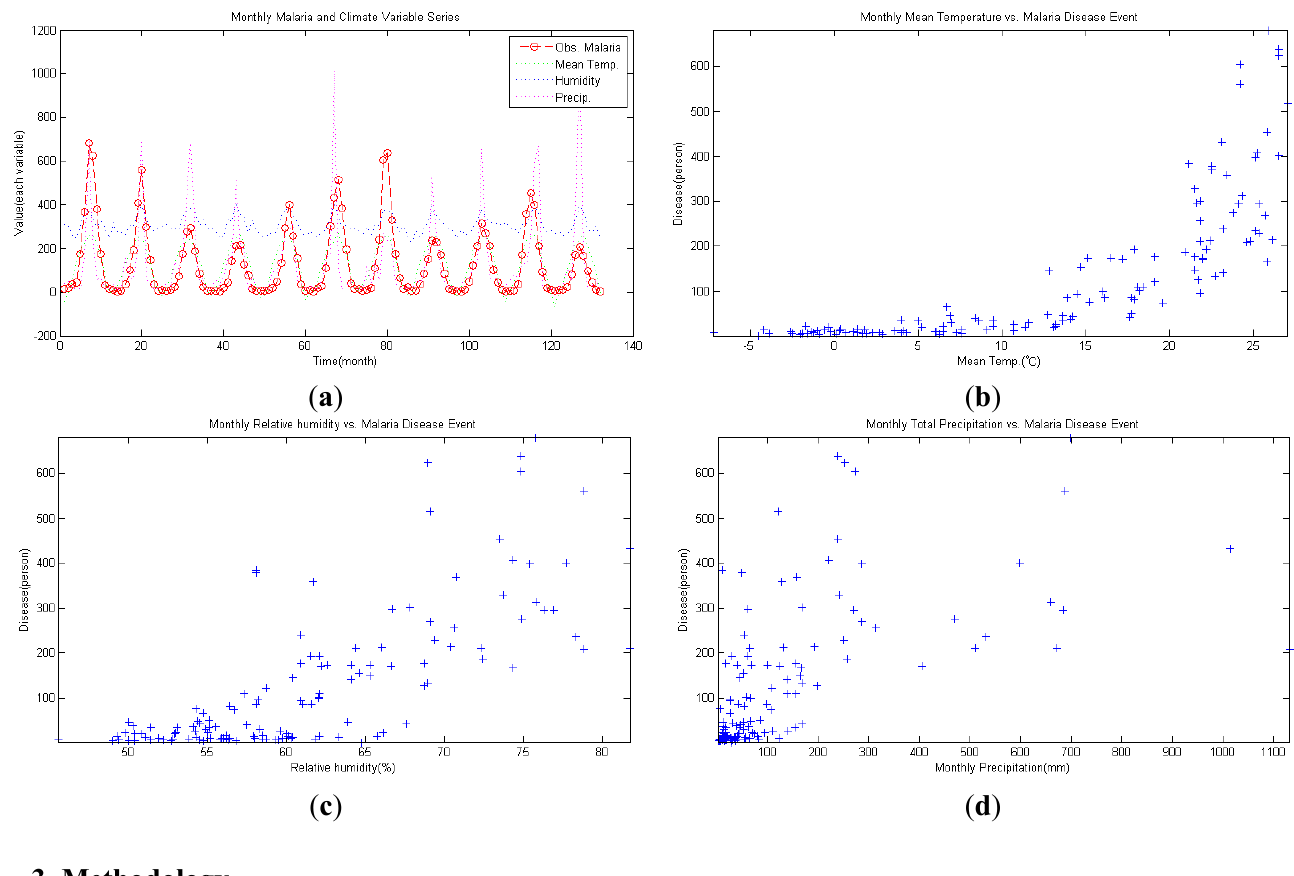
Figure 1. ( a ) Time series of each variable; ( b ) scatter diagram of mean temperature and malaria; ( c ) scatter diagram of relative humidity and malaria; ( d ) scatter diagram of monthly precipitation and